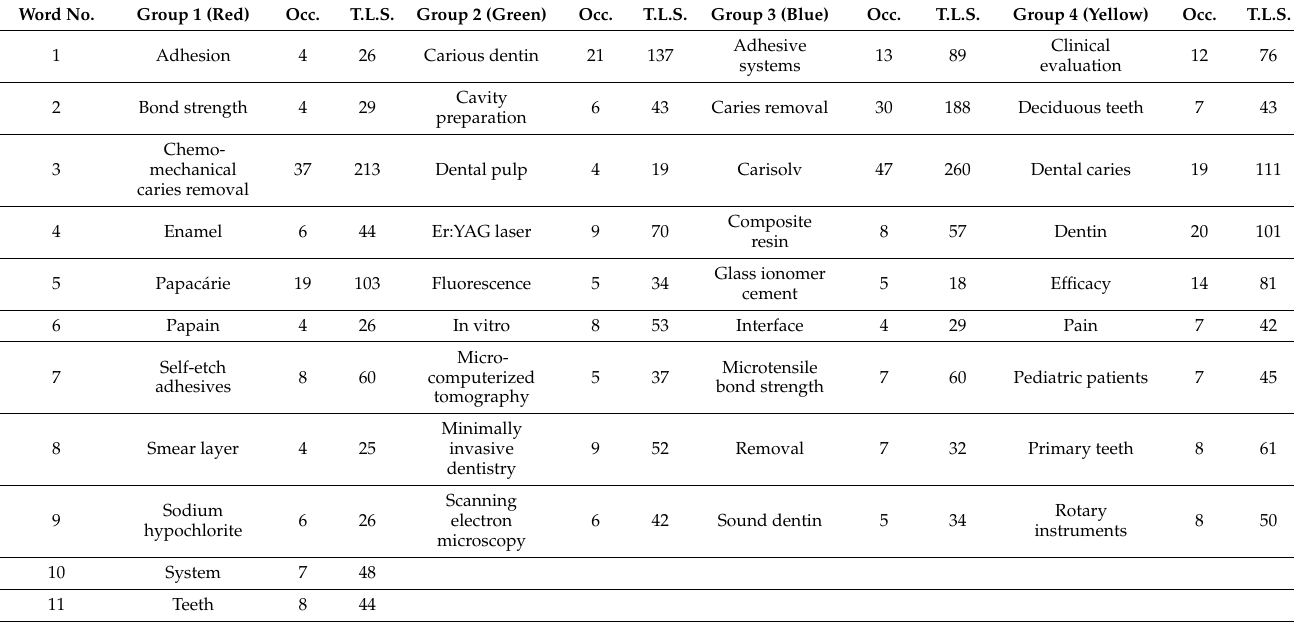
Table 1. Keyword groups. Source: own processing through